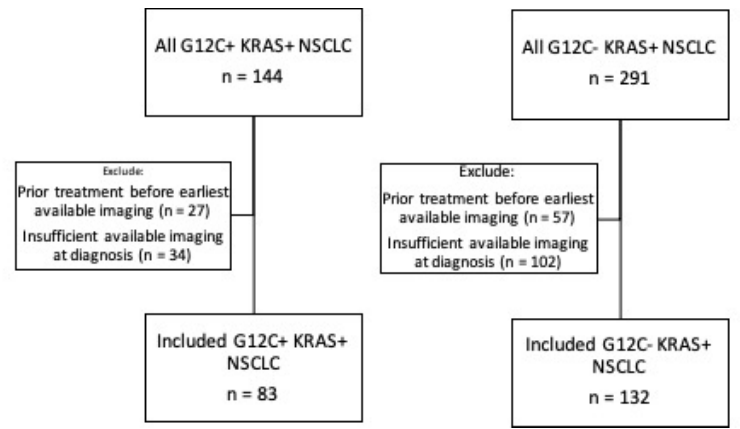
Figure 1. Inclusion and exclusion of patient cohorts.